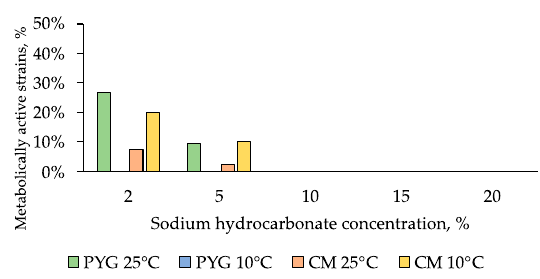
Figure 8. Isolated strains resistance to: ( a ), ( b )—magnesium sulphate; ( c ), ( d )—magnesium perchlorate, ( e ), ( f )—antibiotics. Left column: strains isolated on PYG medium; right column—strains isolated on CM medium. Amp —ampicillin; Chl —chloramphenicol; Rif —rifampicin; Tetr — tetracycline; Kan —kanamycin; Dox —doxycycline; Ceph —cephalexin.